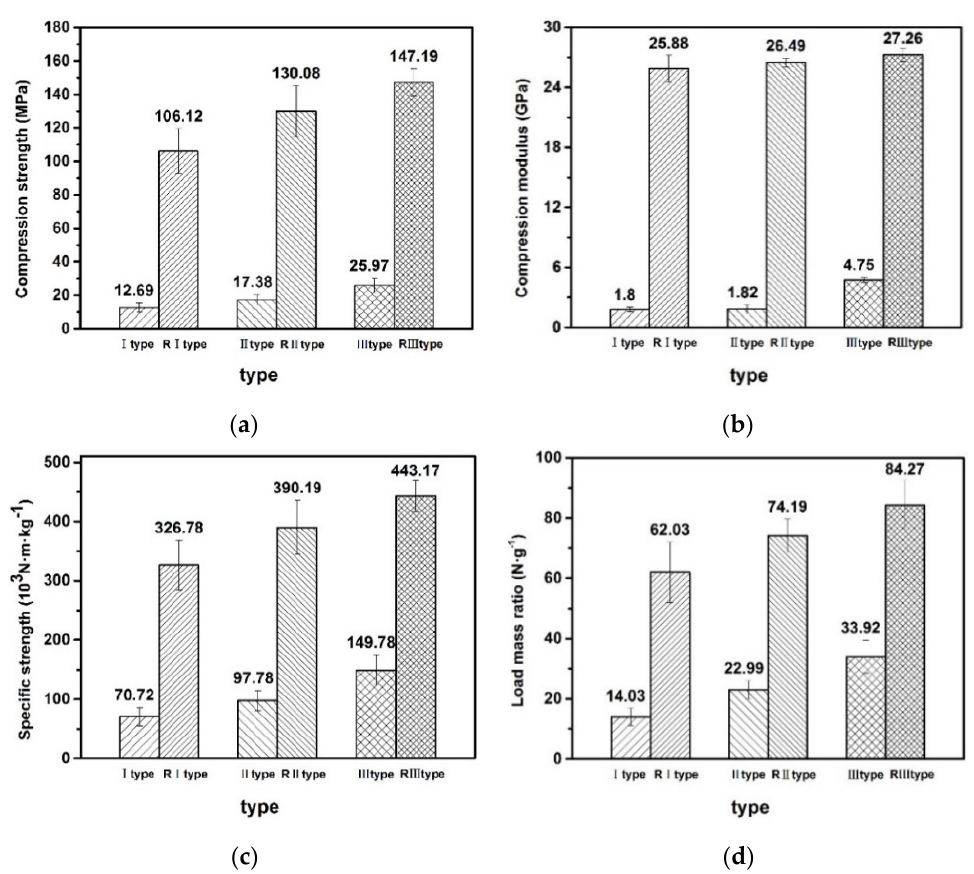
Figure 8. The analysis and comparison of six specimens of the prefabricated 2D wooden pyramidal lattice truss core sandwich structure: ( a ) compression strength, ( b ) compression modulus, ( c ) specific strength, and ( d ) load mass ratio .